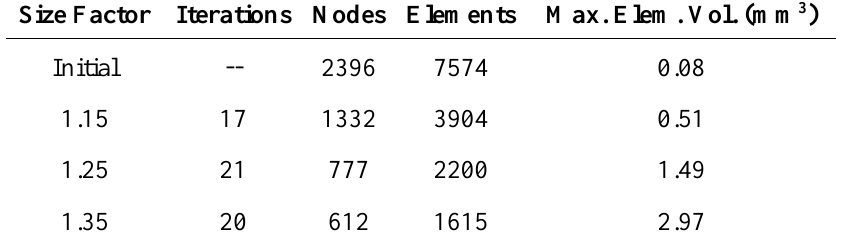
Table 1. Mesh characteristics at convergence under various size factor ranges.